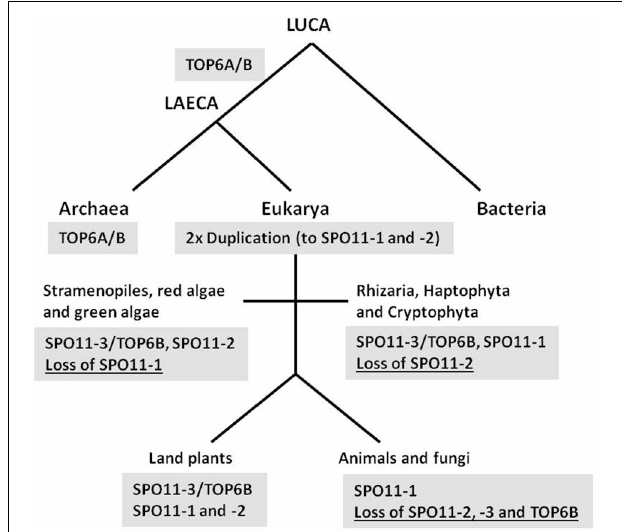
FIGURE 4 | Proposed evolution scheme of SPO11 by two duplications and different loss events. The proposed evolution of the three different SPO11 genes nowadays found in land plants is shown schematically. Whereas bacteria do not possess a topoisomerase 6, LAECA has developed a topoisomerase type 6 from which the subunit TOP6A is orthologous to SPO11-3 in eukaryotes. Two duplication events of SPO11-3 took place after separation of eukarya from archaea resulting in the additional SPO11-1 and SPO11-2 genes. In different phyla loss events of either SPO11-1 or -2 occurred. After separation of the animal and fungal kingdom SPO11-2 and -3 as well as TOP6B must have been lost resulting in the remaining single SPO11 gene present in these two kingdoms. Abbreviations: LUCA, last universal common ancestor; LAECA, last archaeal-eukaryal common ancestor. The term LAECA was taken from Forterre